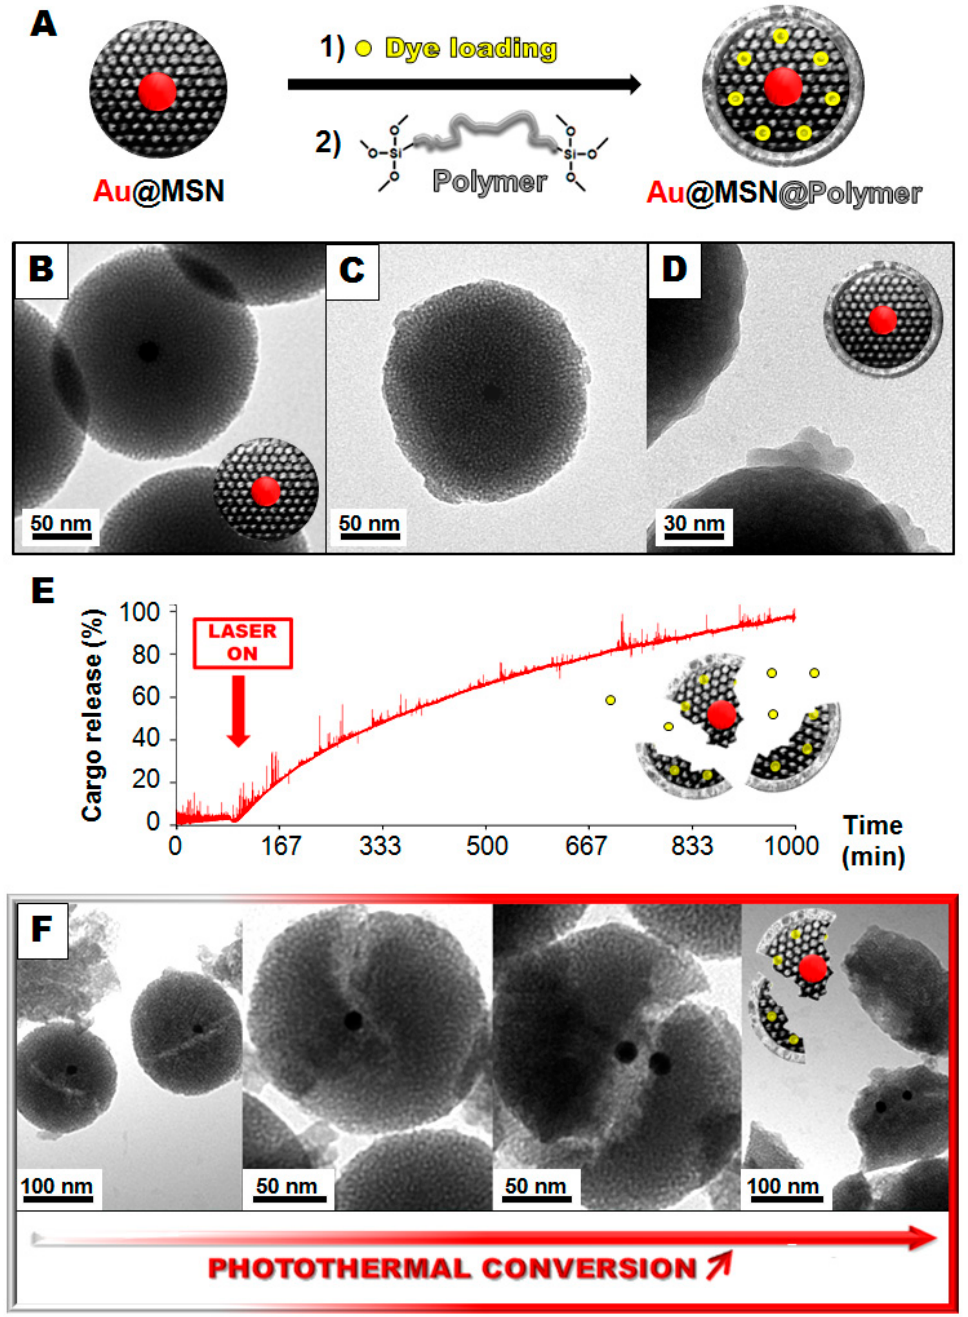
Figure 6. Schematic representation of the dye loading and polymer coating of Au@MSN ( A ). TEM micrographs before ( B ) and after polymer coating ( C , D ). Light-triggered cargo release in solution (514 nm, 30 mW) ( E ). TEM photodegradation of the dye-loaded Au@MSN@polymer nanoparticles after 7 h of release experiment ( F ).